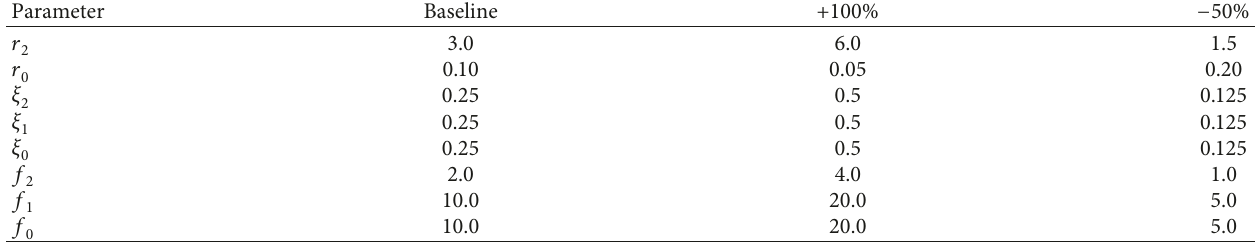
Table 2: The values of the system parameters for the analysis.